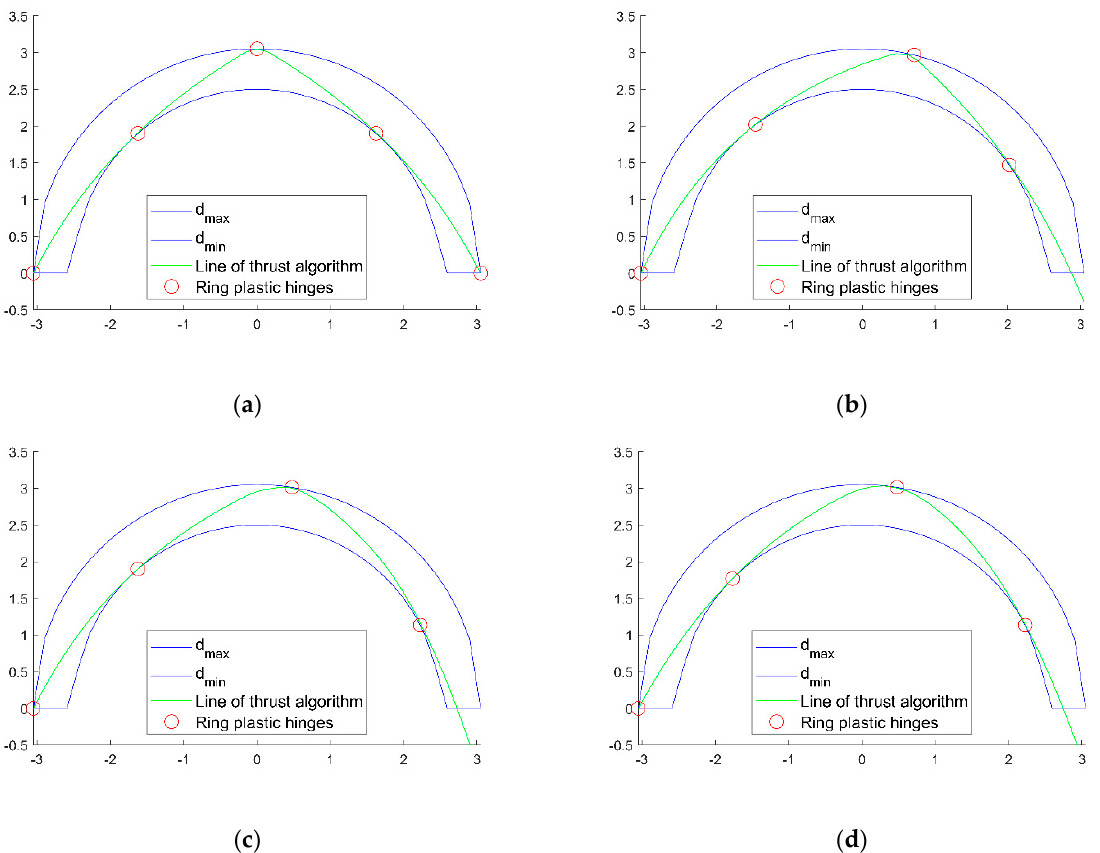
Figure 6. Lines of thrust obtained with the numerical algorithm for each case study, in comparison with the plastic hinges position obtained with the software Ring: ( a ) case study 1, ( b ) case study 2, ( c ) case study 3, ( d ) case study 4.